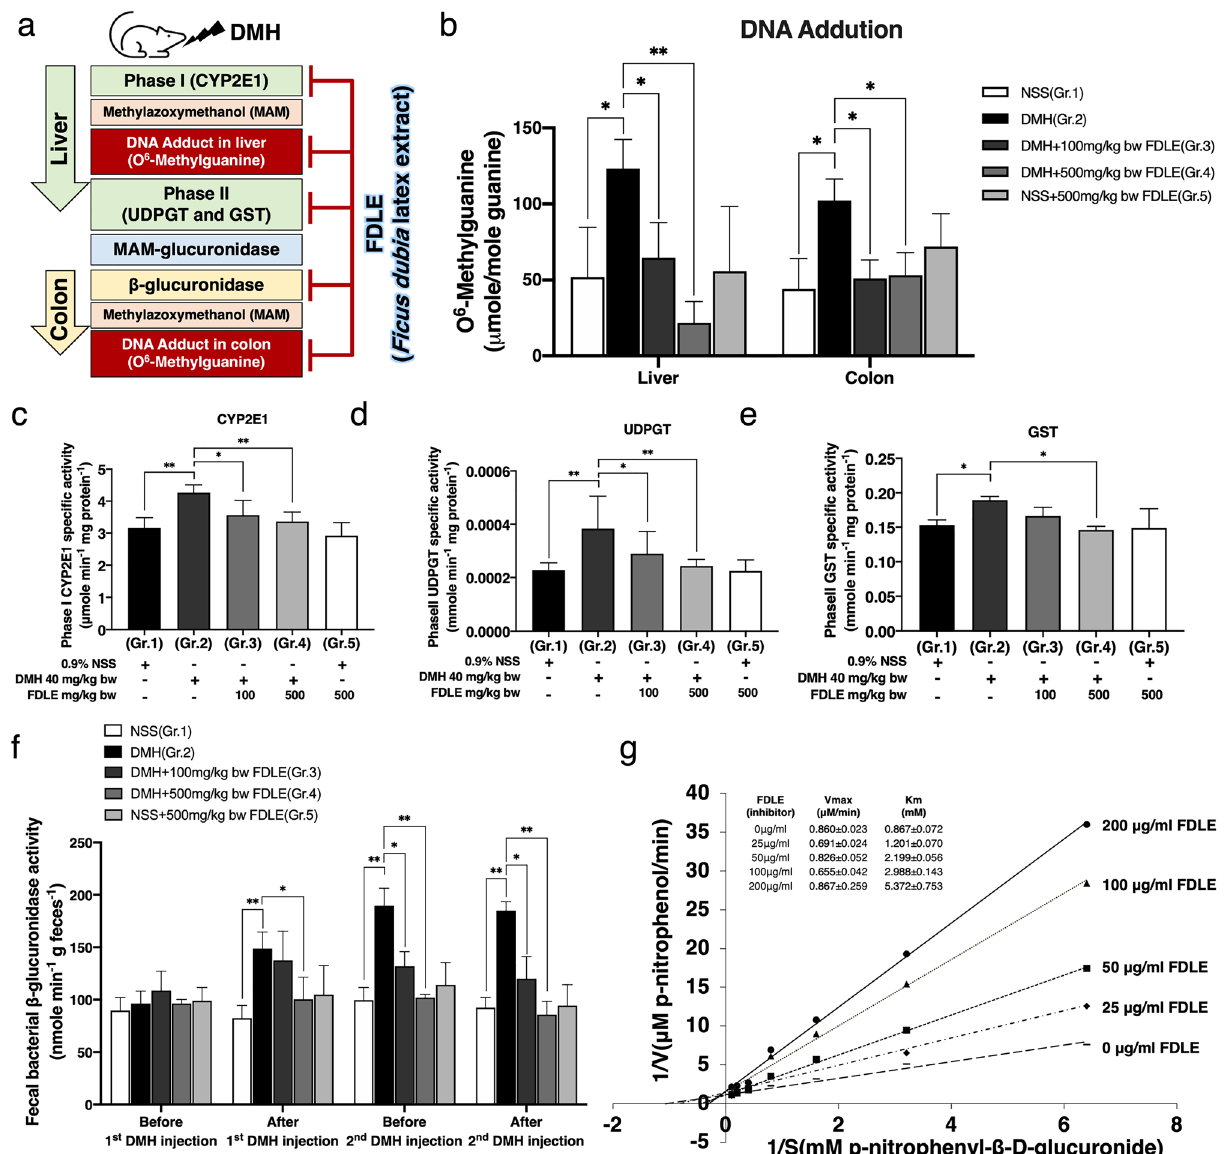
Figure 3. Effect of FDLE on the metabolism of dimethylhydrazine and DNA adduct formation in rat liver and colon ( a ) scheme of inhibitory effect of Ficus dubia latex extract on DMH-induced carcinogenesis. ( b ) The level of O 6 -MeG DNA adducts in liver tissue and colonic mucosa. ( c ) The activity of phase I and II xenobiotic metabolizing enzymes in rat liver tissue, cytochrome P4502E1 (CYP2E1) catalyzed PNP-hydroxylation, ( d ) UDP-glucuronosyltransferase (UDPGT) and ( e ) Glutathione-S-transferase (GST), phase II detoxifying enzymes. ( f ) The activity of bacterial β-glucuronidase in rat feces. ( g ) Lineweaver–Burk plot of E. coli β-glucuronidase in the presence of FDLE with data representing three independent experiments with similar results. Rat experiments data are presented as the mean ± SD of five rats per group. *p < 0.05, **p <